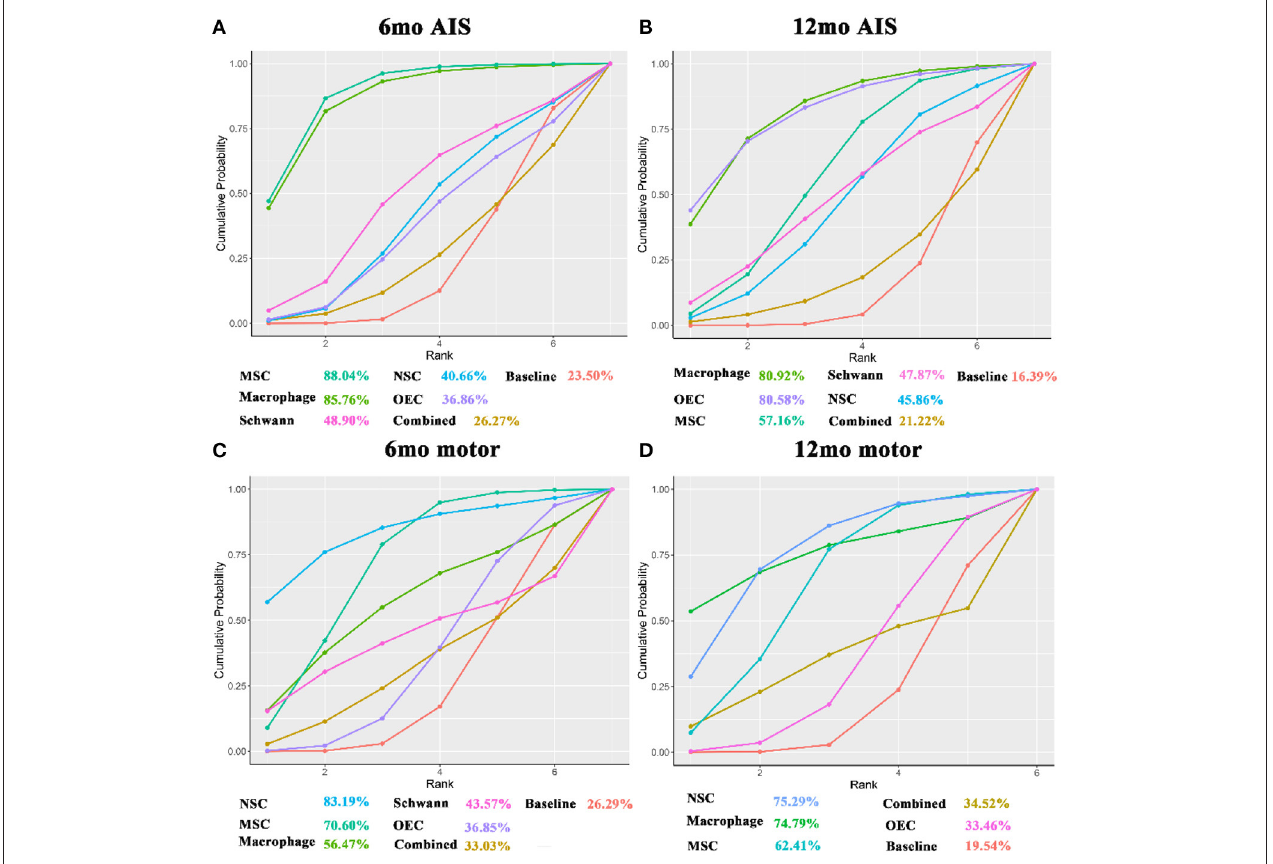
FIGURE 5 | SUCRA for AIS grade and ASIA motor score. (A) SUCRA for 6mo AIS grade; (B) SUCRA for 12mo AIS grade; (C) SUCRA for 6mo ASIA motor score; (D) A network plot for 12mo ASIA motor score. The x-axis represents the ranking and the y-axis represents the cumulative probability. The cumulative ranking and cumulative probability are constructed as a curve. The larger the area under the curve, the greater the benefit of the intervention. AIS grade, American Spinal Cord Injury Association (ASIA) Impairment Scale; mo, month; SUCRA, the surface under the cumulative ranking; MSC, mesenchymal stem cell; NSC, neural stem cell/neural progenitor cell; OEC, olfactory ensheathing